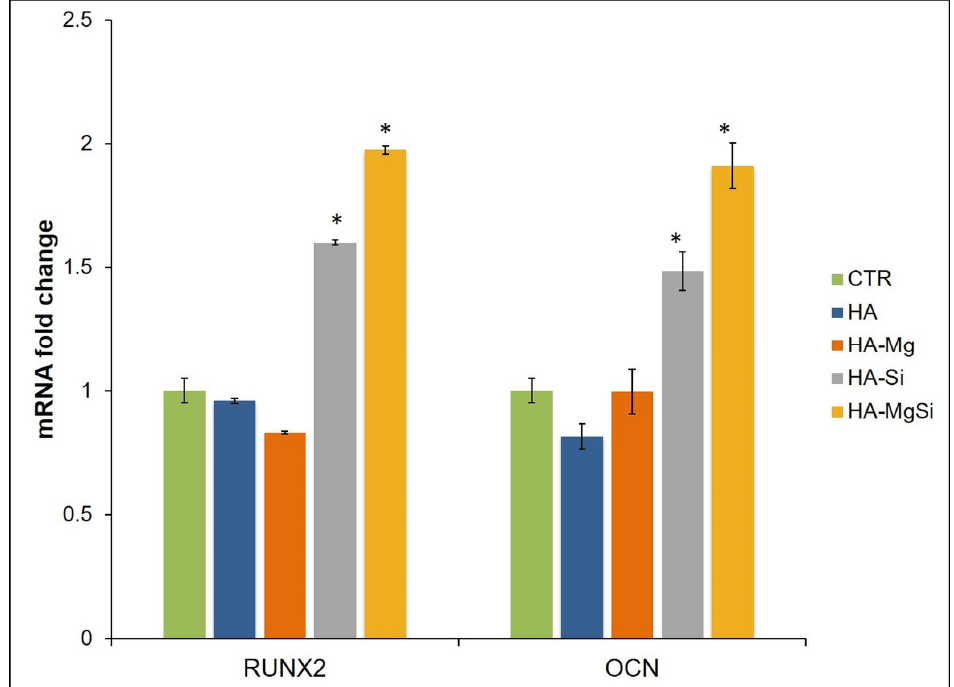
Figure 11. Effect of ceramic scaffolds on osteogenic gene expression. mRNA abundance of RUNX2, OCN in BMSC seeded on scaffolds and cultured in basal medium for 28 days. Gapdh was used as a housekeeping gene for normalization. Fold change in mRNA expression was relative to control (CTR) represented by BMSC seeded into well plates. Results were expressed as the means ± SD of triplicate measurements from three independent experiments (* p < 0.05 vs. CTR). The increase in ALP activity on the 14th day and of osteogenic marker mRNA levels on the 28th day confirms the ability of HA-Si and HA-MgSi scaffolds to promote osteo- blast differentiation. Indeed, since it is known that ALP is involved in extracellular matrix mineralization, its activity rises in the early phase of the osteoblast differentiation process, and then it declines when osteoblasts differentiate to osteocytes. By contrast, RUNX2 and OCN expression increases later, and it is essentially typical of osteoblasts in the post-pro- liferative phase [36,38]. It has been reported that negatively charged surfaces show better cell attachment, proliferation and osteoblast differentiation than untreated hydrophobic surfaces [39]. These results suggest that the microstructure, mechanical properties and charge features of HA-Si and HA-MgSi play crucial roles in cell adhesion, growth and differentiation, although the phenomenon of cell–surface interaction is very complex; therefore, it is not yet clear which property could be dominant for cell adhesion and growth on surfaces. Taken together, our data demonstrated that these materials not only exhibit excellent performance in terms of biocompatibility and cell viability, but they also could provide a strong osteogenic commitment to mesenchymal stem cells.